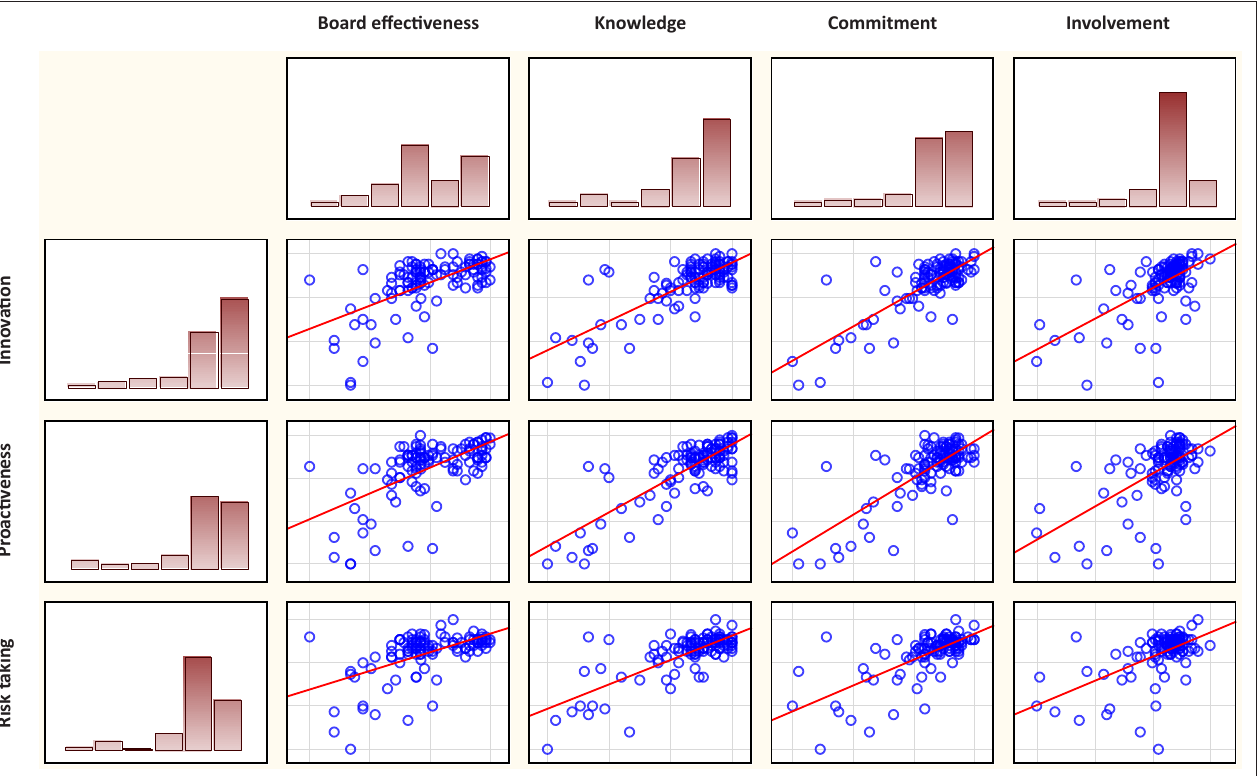
FIGURE 1: Matrix plot for the linear relations between corporate governance systems and entrepreneurial orientation TABLE 4: Correlation matrix for corporate governance systems and entrepreneurial orientation dimensions. Dimensions